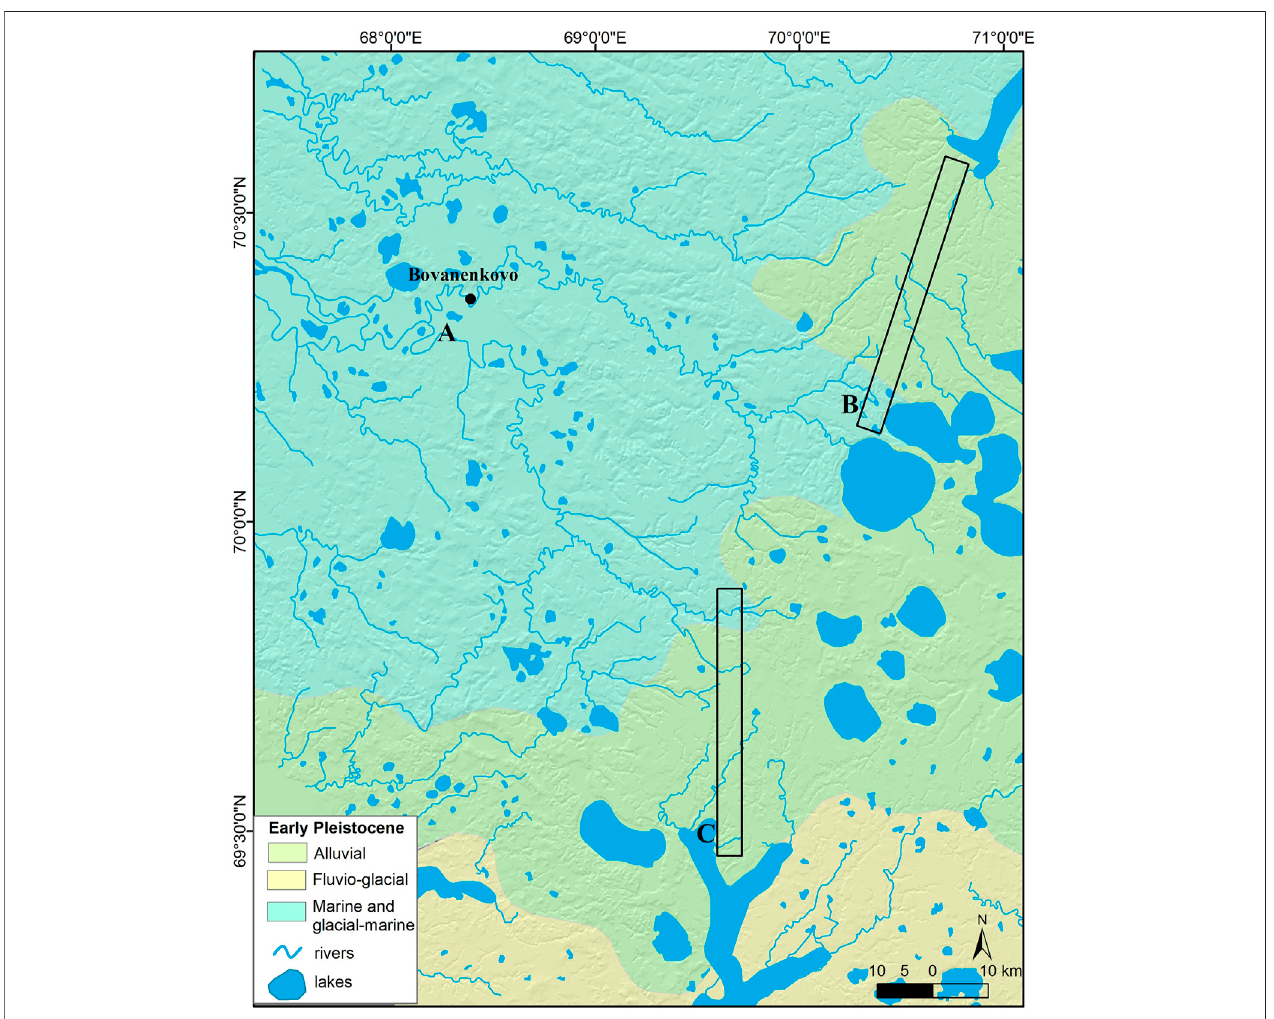
FIGURE 2| Geology map of the study area. The map is modi fi ed after Food and Agriculture Organization (FAO) of the United Nations project de fi ned geology map of the western Siberia.